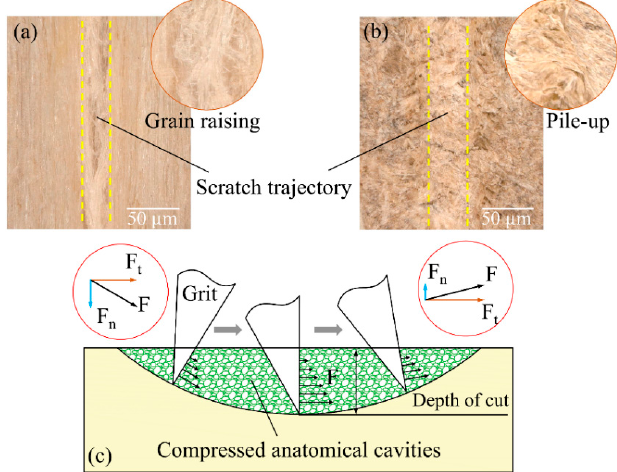
Figure 7. Analysis of plastic material deformation and chip formation when scratching Korean Pine ( λ = 0°) and MDF: ( a ) Ultra-Depth 3D Microscopic images of Korean Pine scratched surface; ( b ) Ultra-Depth 3D Microscopic images of MDF scratched surface; ( c ) the diagram of force analysis of workpiece within the arch trajectory path.